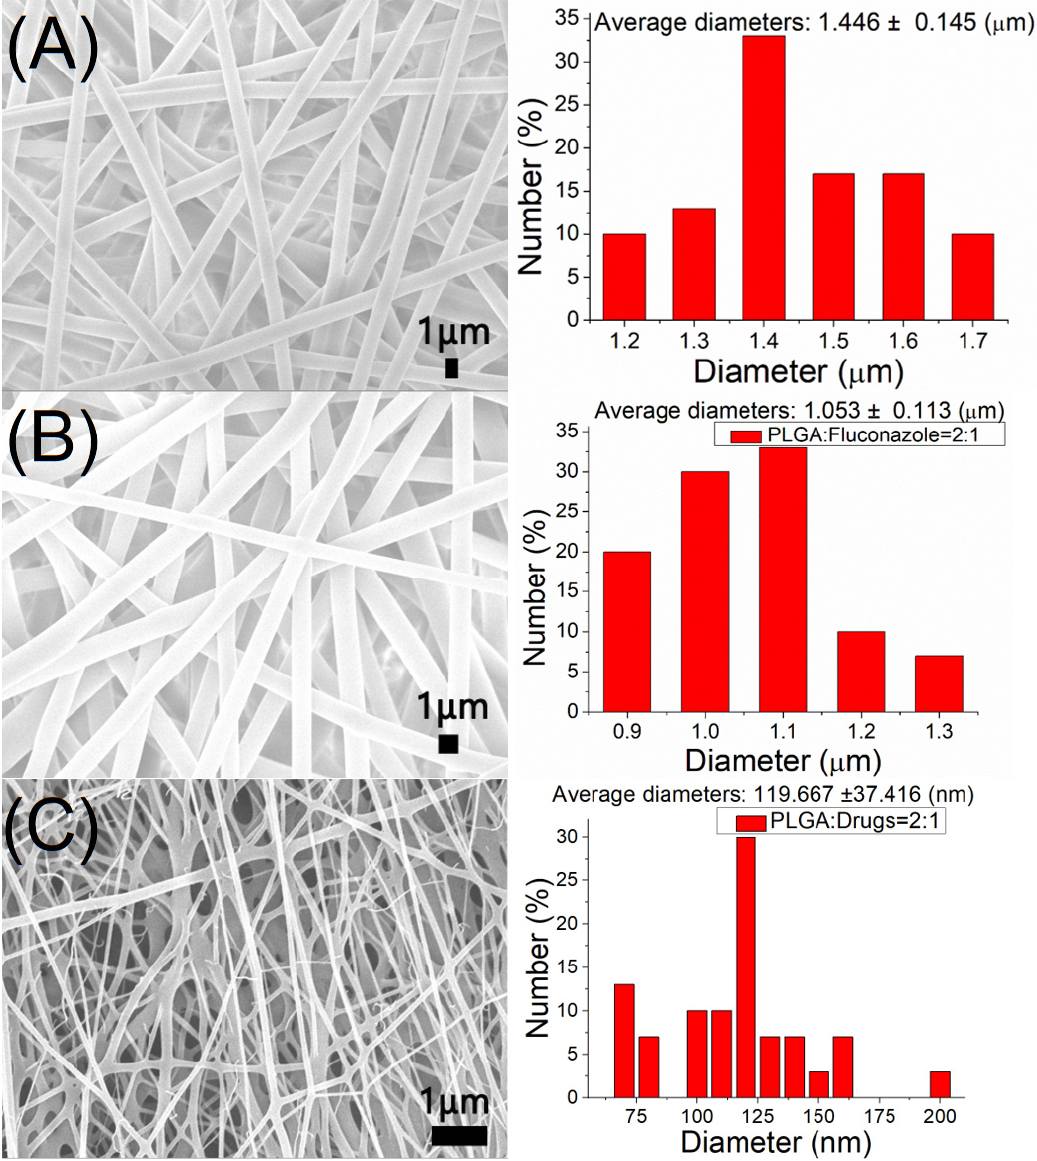
Figure 1. Scanning electron microscopy images and fiber diameter distributions of: ( A ) pristine poly lactic- co- glycolic acid (PLGA), ( B ) fluconazole-loaded nanofibers, and ( C ) vancomycin/ceftazidime- loaded nanofibers.